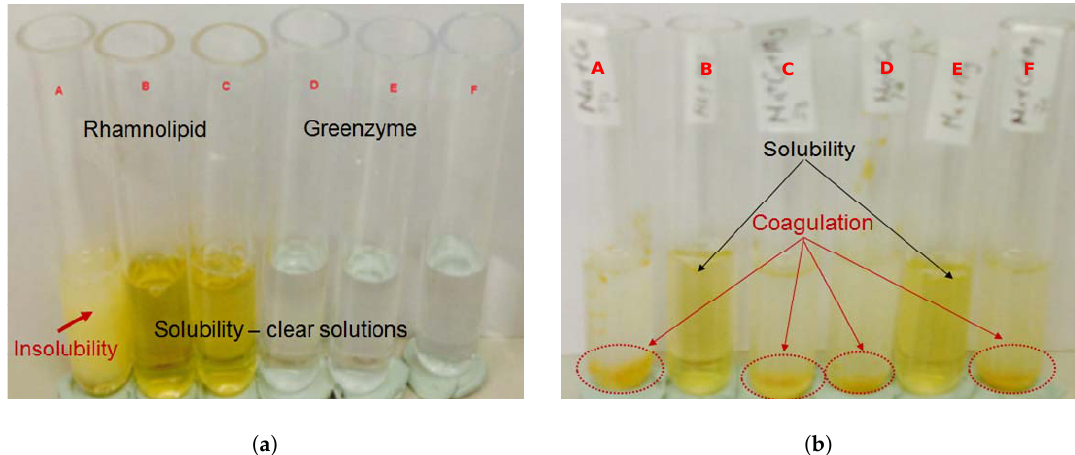
Figure 3. Illustration of biosurfactants solubility: ( a ) Solubility of Greenzyme and rhamnolipid in aqueous solution illustrated: (A) an example of rhamnolipid precipitation, (B,C) examples of rhamnolipid solubility (D–F) examples of Greenzyme solubility; ( b ) rhamnolipid solubility behaviour under different temperature: (A, C, D and F) are examples of solutions in which rhamnolipid was insoluble at low temperature and coagulation was observed at high temperatures while (B and E) are examples of solutions in which rhamnolipid was soluble at low temperature and still soluble at high temperature.